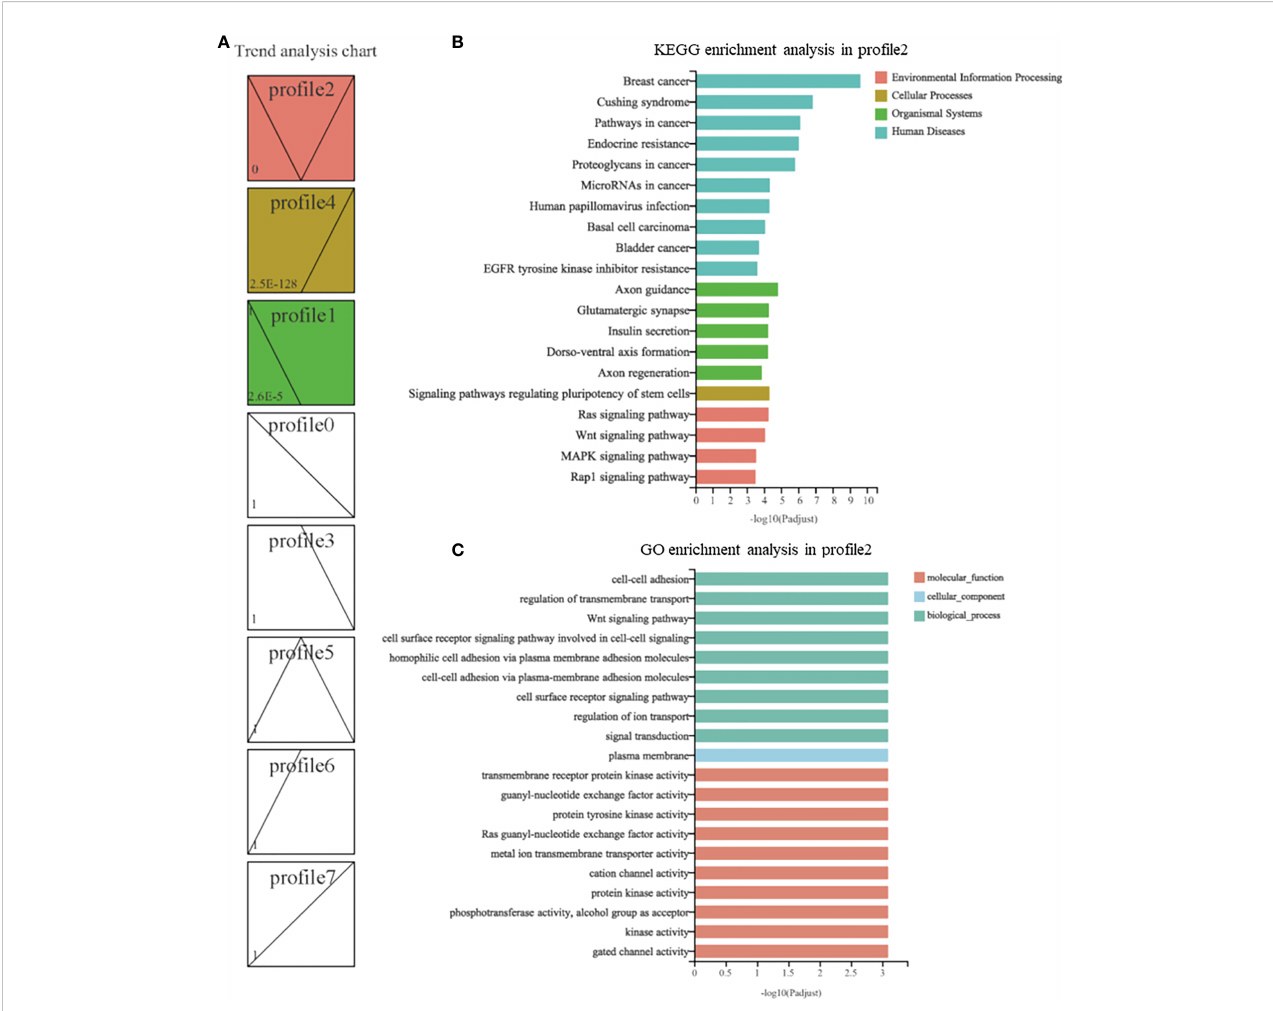
FIGURE 7 Trend analysis of genes in R. venosa transcriptome. (A) Different expression patterns of all genes. Each box represents a model pro fi le. The upper number in the box represents the serial number of pro fi les and the lower one is the P value. Boxes with P values <0.05 are colored. GO (B) and KEGG (C) enrichment analysis of genes in pro fi le